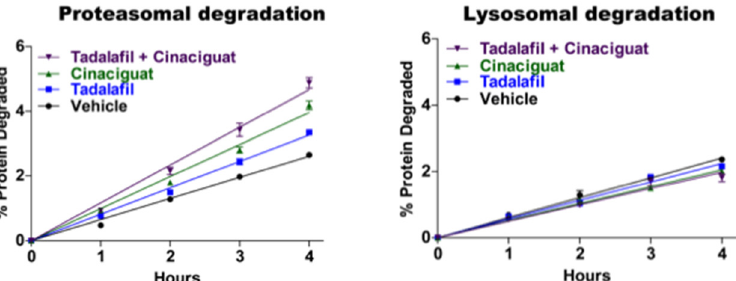
Figure 7. Agents that raise cGMP increase the degradation of proteins by the UPS, but not by autophagy. Proteins in SY5Y cells were prelabeled with 3 H-phenylanine for 20 h to label long-lived cell proteins as described previously [62,64]. Proteasomal degradation reflects the net decrease in total protein breakdown in the presence of the proteasome inhibitor bortezomib. Lysosomal degradation represents the net decrease in the presence of the inhibitor of lysosome acidification concanamycin A (adapted from [16]).